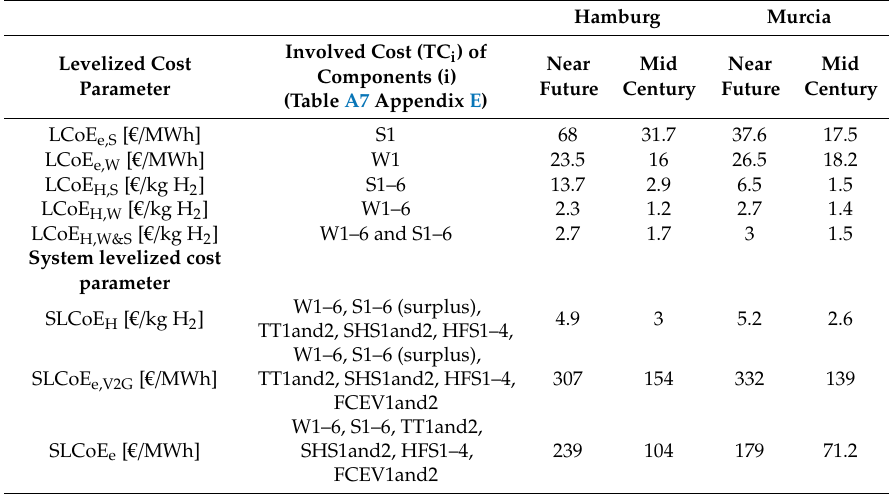
Table 4. Levelized (LCoE) and system levelized cost of energy (SLCoE) parameters for Hamburg and Murcia in the Near Future and Mid Century